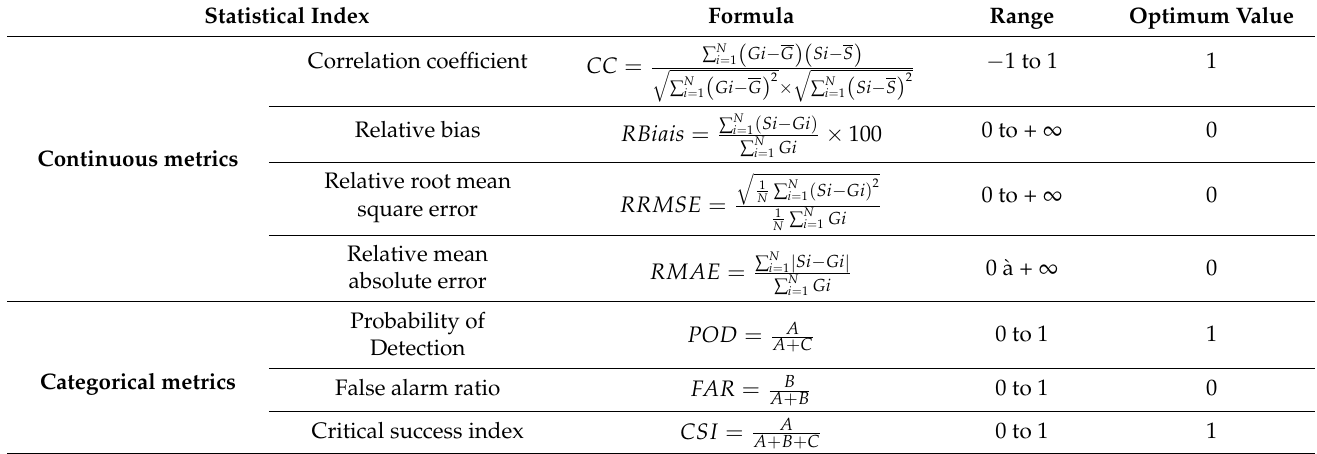
Table 3. List of Continuous and Categorical metrics used in this study. Gi: the gauge observation; Si: the satellite precipitation estimation; S: the mean satellite precipitation estimation; G: the mean gauge observation; N: the sample size; A–C: see the contingency table (Table 4).